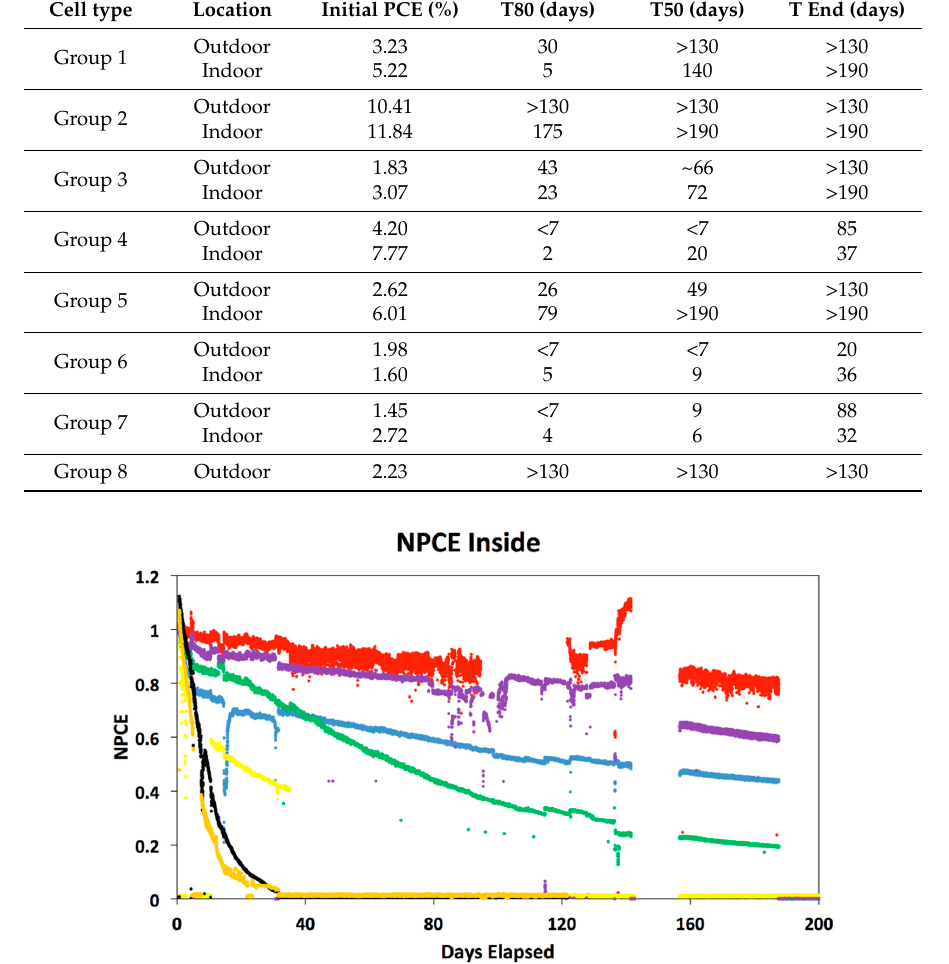
Table 1. Characterization of cells in study.